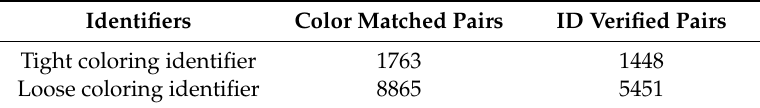
Table 5. Matched compounds detected by the compound coloring identifiers.